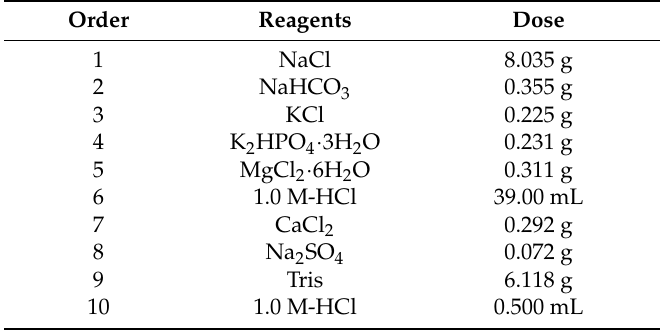
Table 1. Order and amounts of reagents for prepared simulated body fluids solution (SBF). Order Reagents Dose 1 NaCl 8.035 g NaHCO